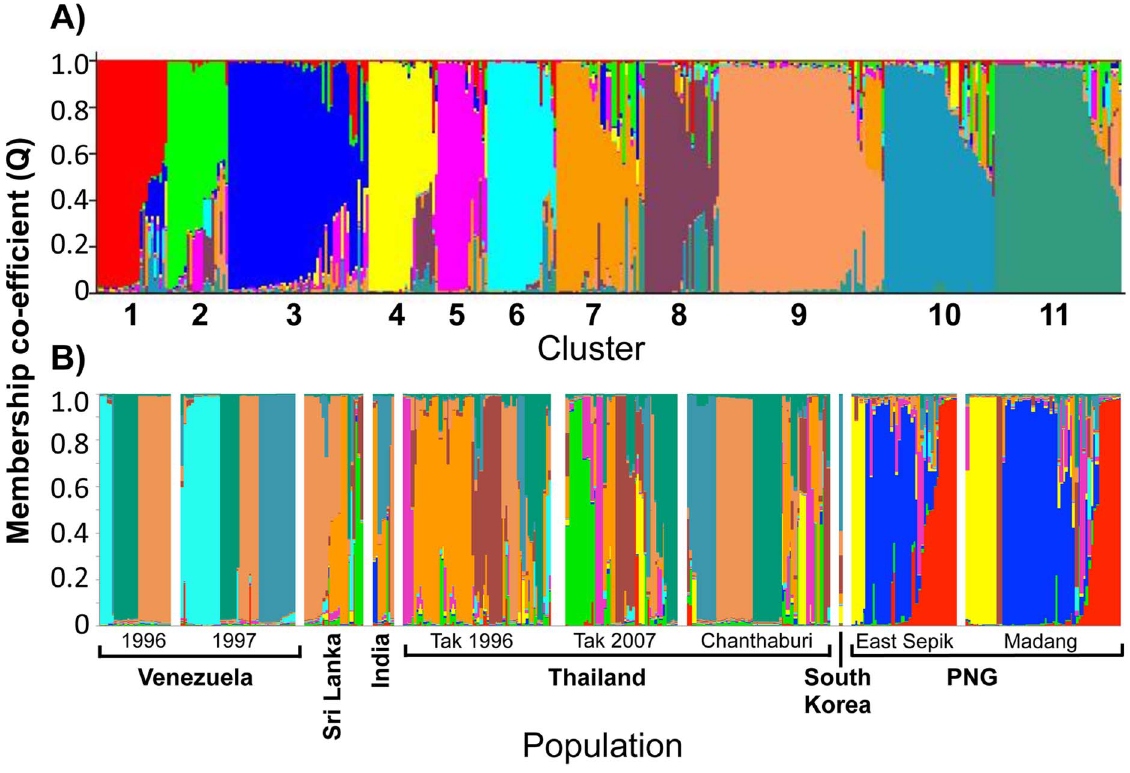
Figure 5. Clustering patterns of Pv AMA1 haplotypes. S TRUCTURE analysis of Pv AMA1 haplotypes composed of 23 common amino acid polymorphisms. Haplotypes are shown according to A) the membership coefficient (Q) and B) geographic distribution of eleven clusters (K=11).